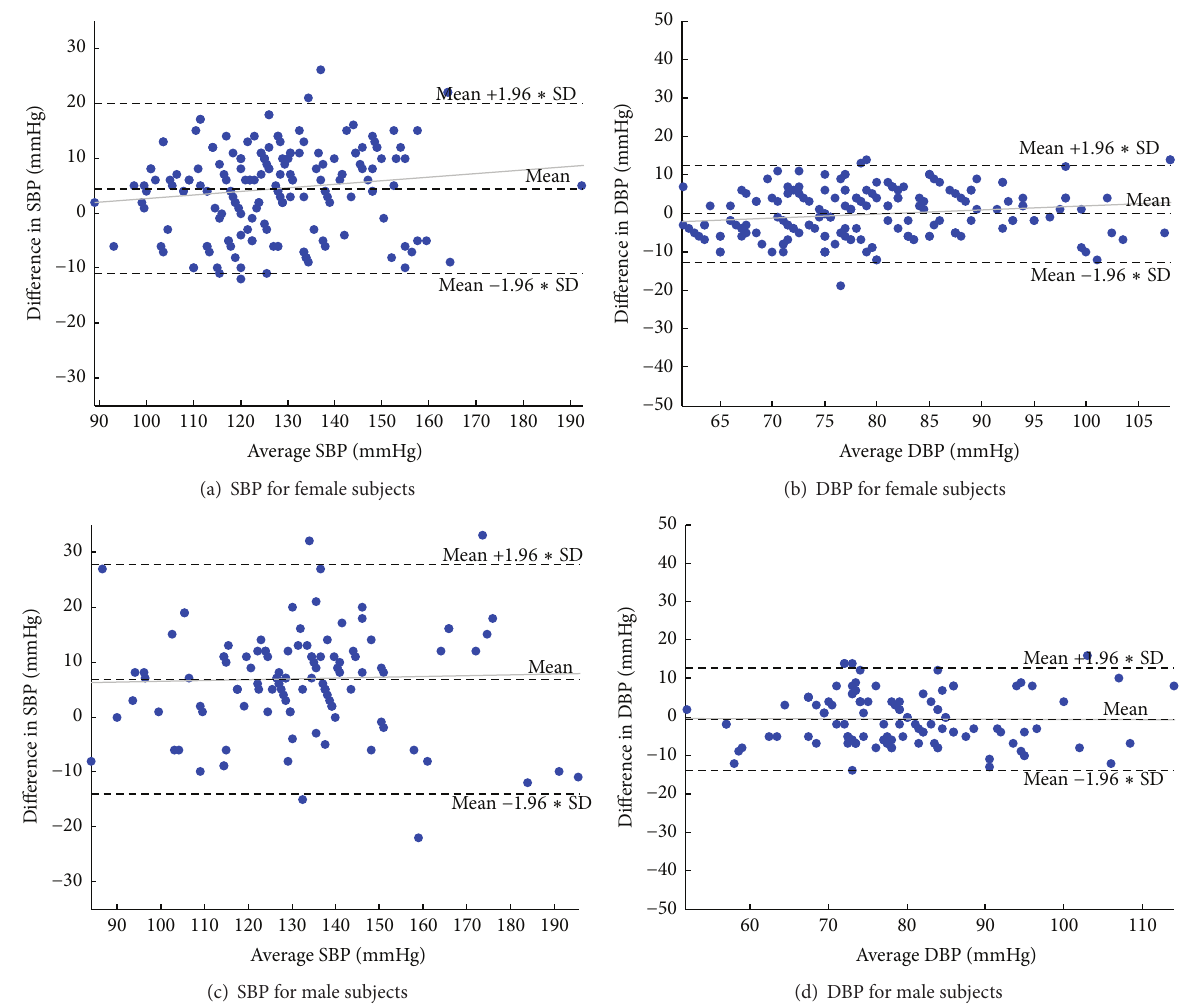
Figure 8: Scatter plot of difference and average of parameters taken by wrist sensor method and sphygmomanometric method.